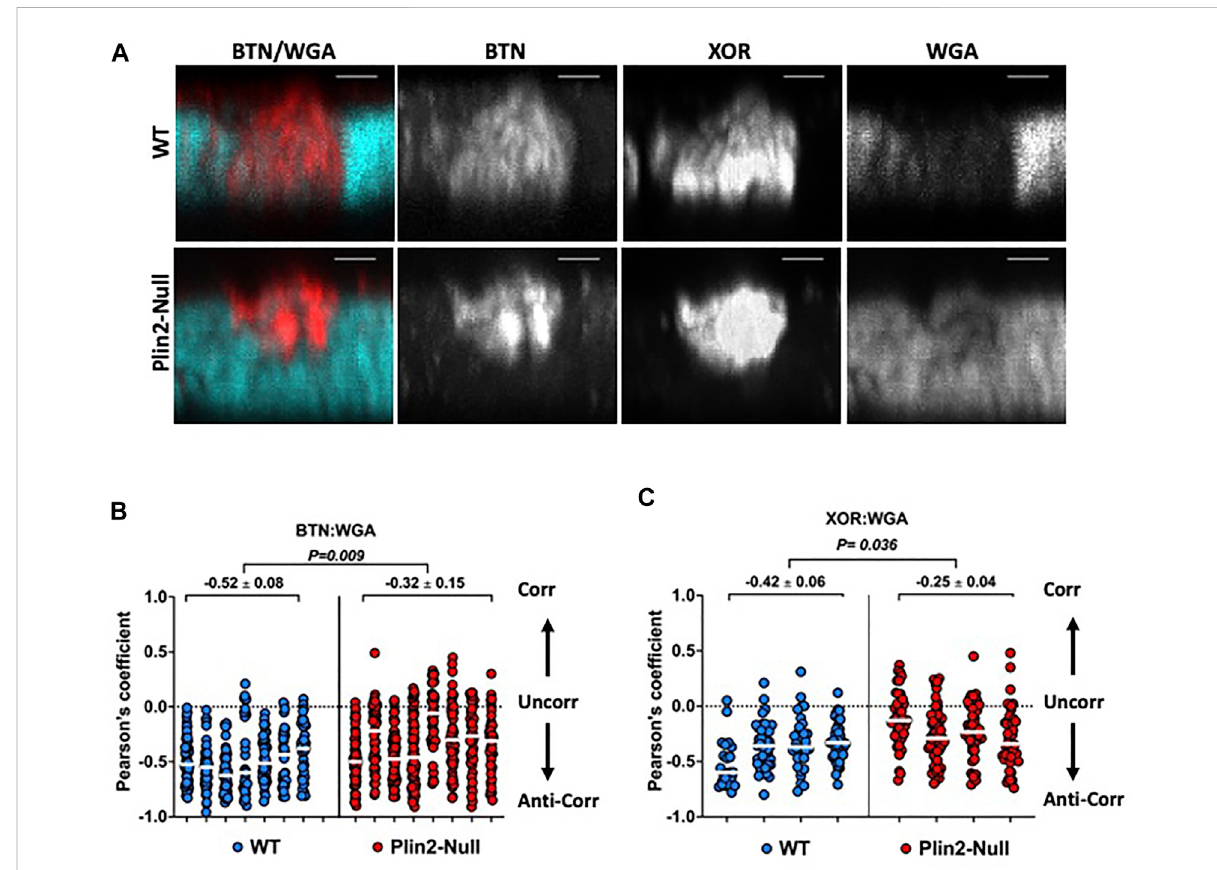
FIGURE 5 Glycocalyx remodeling at LD-APM contacts. (A) Representative 3D-projection images of mammary gland sections prepared from WT or Plin2- Nulldamsfollowingremovaloftheirlittersfor2 hatL10toinhibitmilksecretion. ThesectionswereimmunostainedwithantibodiestoBTNandXOR to identify LD-APM contacts and with Alexa633-tagged WGA ( fl -WGA) to identify the glycocalyx. The images show exclusion of fl -WGA (blue green) from a BTN and XOR positive APM domain in WT sMEC, and partial exclusion of fl -WGA from a BTN and XOR positive APM domain in a Plin2 sMEC. Scale bars are 2 µm. (B,C) Pearson ’ s correlation coef fi cients describing the overlap between fl -WGA and BTN (B) or XOR (C) in 40 – 60 sMEC/animal from WT and Plin2-Null dams prepared as described in (A) . Median values are indicated by white bars and average medians ±SEM are shown above each group. p -values for group differences were determined by nested t -test and are shown at the top of each fi gure. Pearson ’ s coef fi cients of 1, 0 and − 1 represent perfect correlation (Corr), no correlation (Uncorr.) and perfect negative correlation (Anti-corr.) respectively as shown in each fi